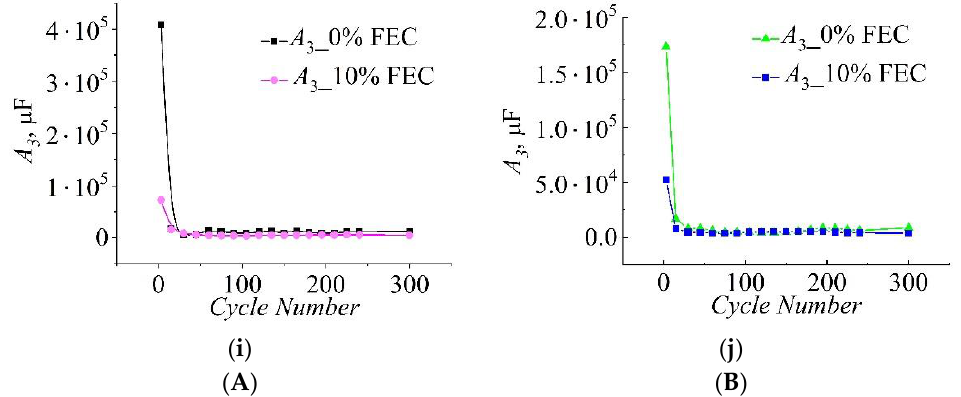
Figure 10. Dependencies of the equivalent circuit parameters on the cycle number for samples with and without FEC. The left column compares the samples of pair ( A ) ( a , c , e , g , i ), and the right compares the samples of pair ( B ) ( b , d , f , h , j ).